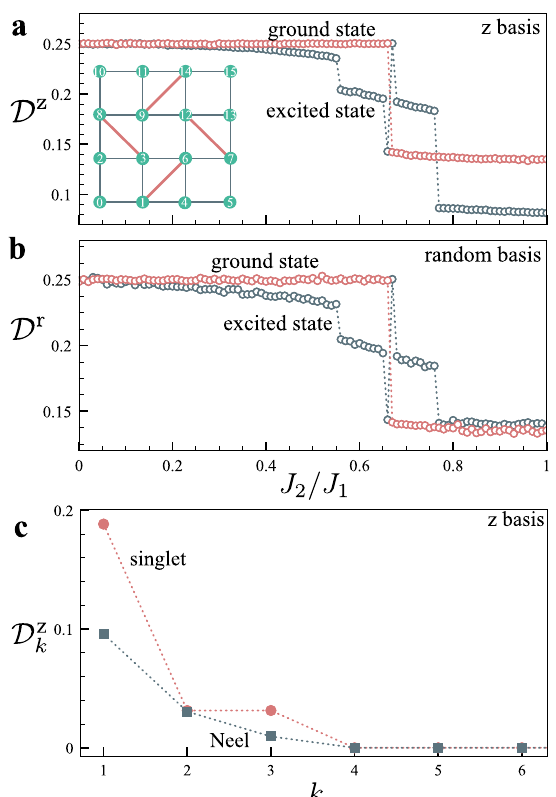
Fig. 8 Dissimilarity results for the Shastry-Sutherland model. Dissimilarity of the ground and the fi rst excited states (with zero total spin) of the Shastry-Sutherland model as a function of the inter-dimer coupling in the σ z ( a ) and the random ( b ) bases. The inset in panel ( a ) shows how spins are grouped to obtain fl attened bitstrings. c Comparison of the partial dissimilarity pro fi les obtained for the singlet ( J 2 = 0) and the Néel ( J 2 = 1) states in the σ z